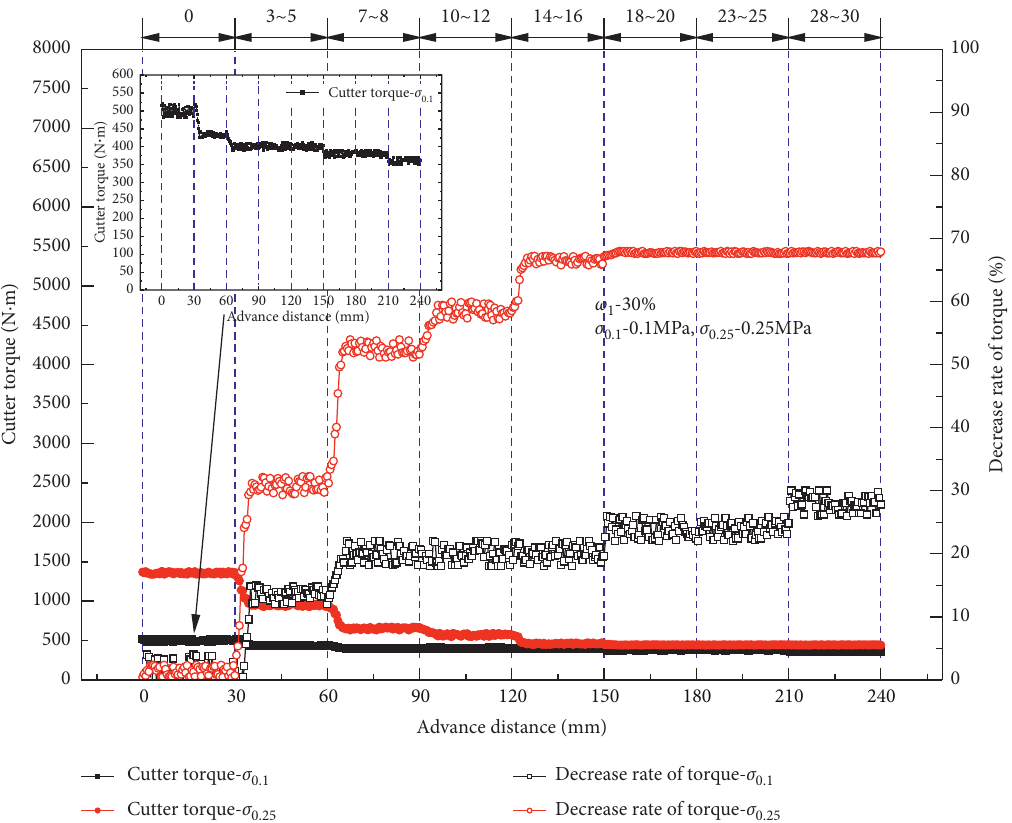
Figure 25: Effect of slurry conditioning and soil pressure on cutter torque at water content